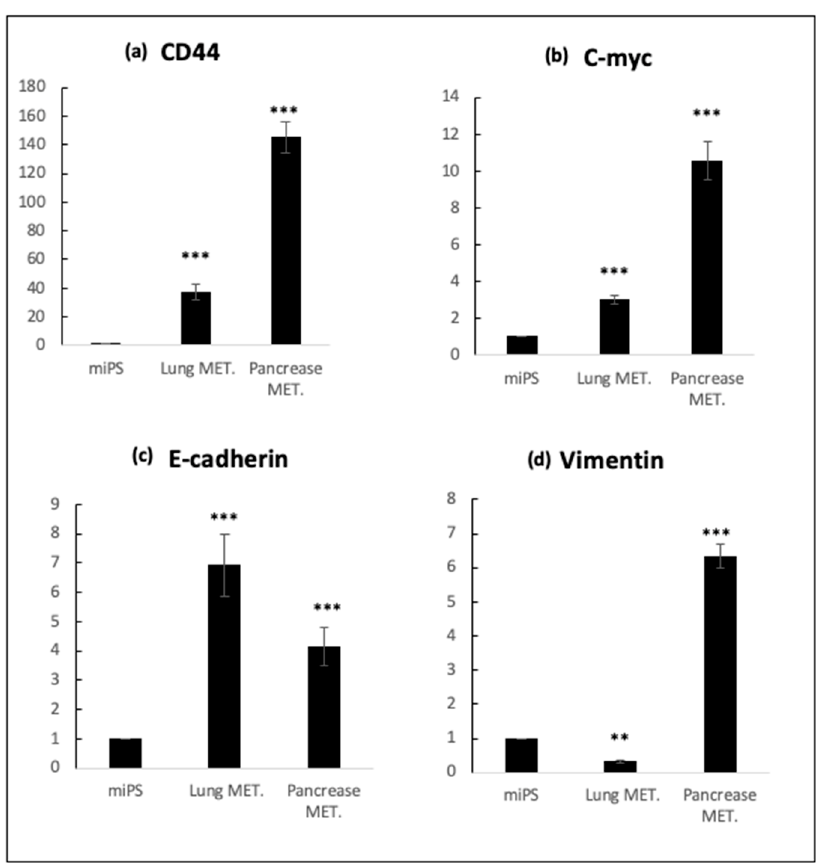
Figure 5. ( a ) RT-qPCR analysis of CSC marker CD44; ( b ) RT-qPCR analysis of stemness marker c-Myc ( c ), ( d ) RT-qPCR analysis of metastatic markers E-cadherin and vimentin in cells derived from intraperitoneal transplantation (lung and pancreatic metastatic cells) in comparison with miPS cells. MET.; Metastasis. (**, p ≤ 0.01; ***, p ≤